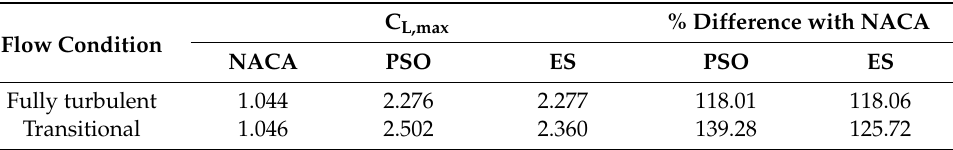
Table 8. Relative increase of C L,max of the PSO and ES airfoils, for fully turbulent and transitional flow, simulations performed by